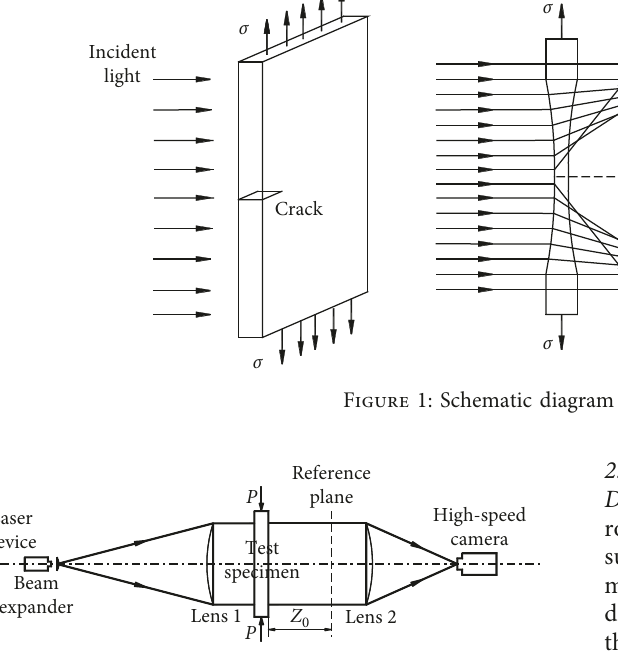
Figure 2: Schematic diagram of the transmission caustics exper- imental